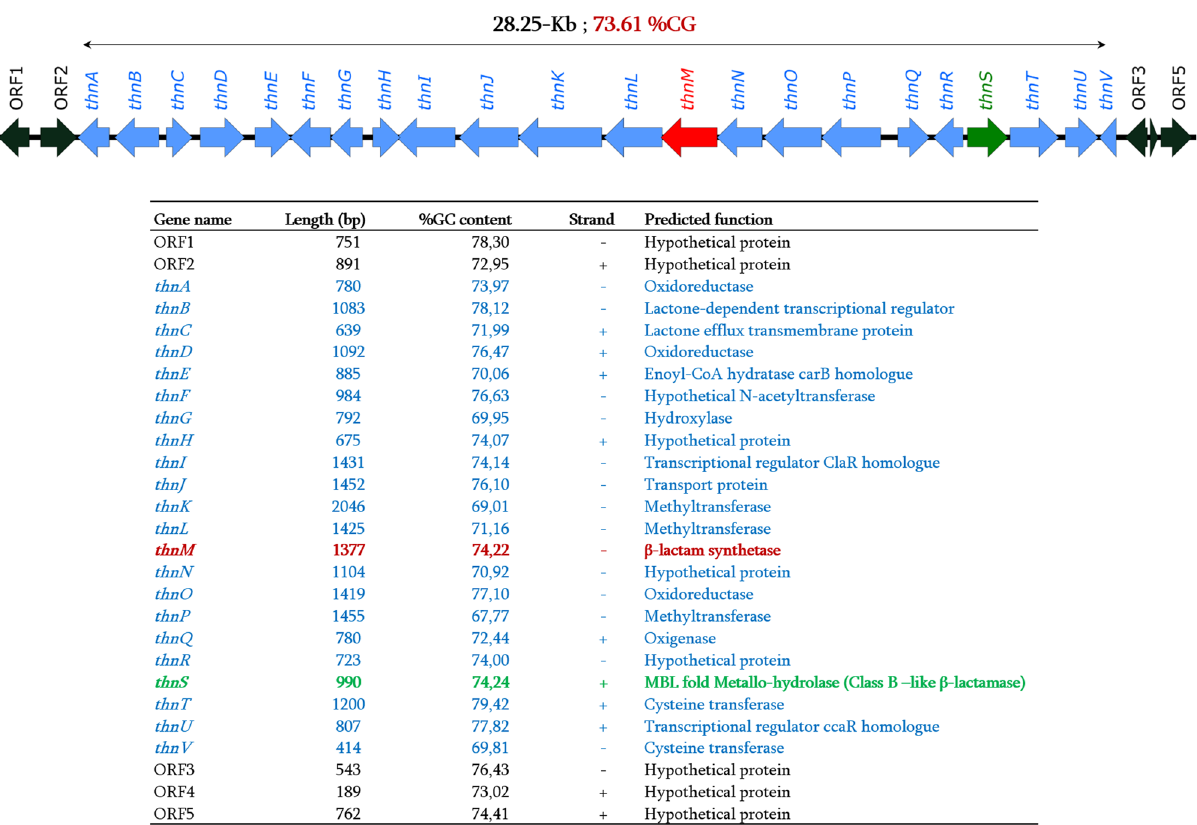
Figure 1. Genetic environment of the thienamycin gene cluster from the megaplasmid of Streptomyces cattleya